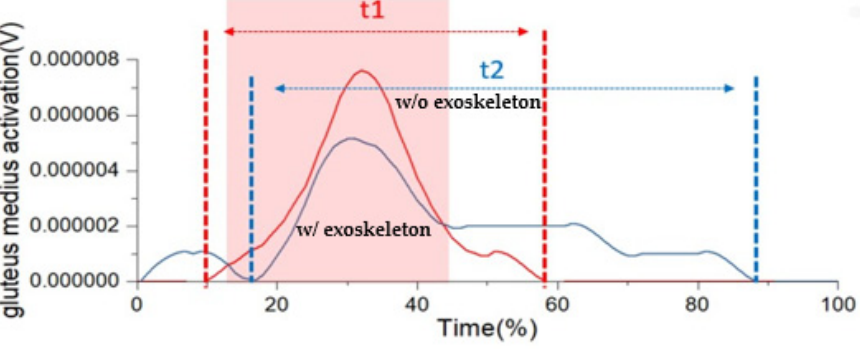
Figure 24. EMG signals of gluteus medius while walking.